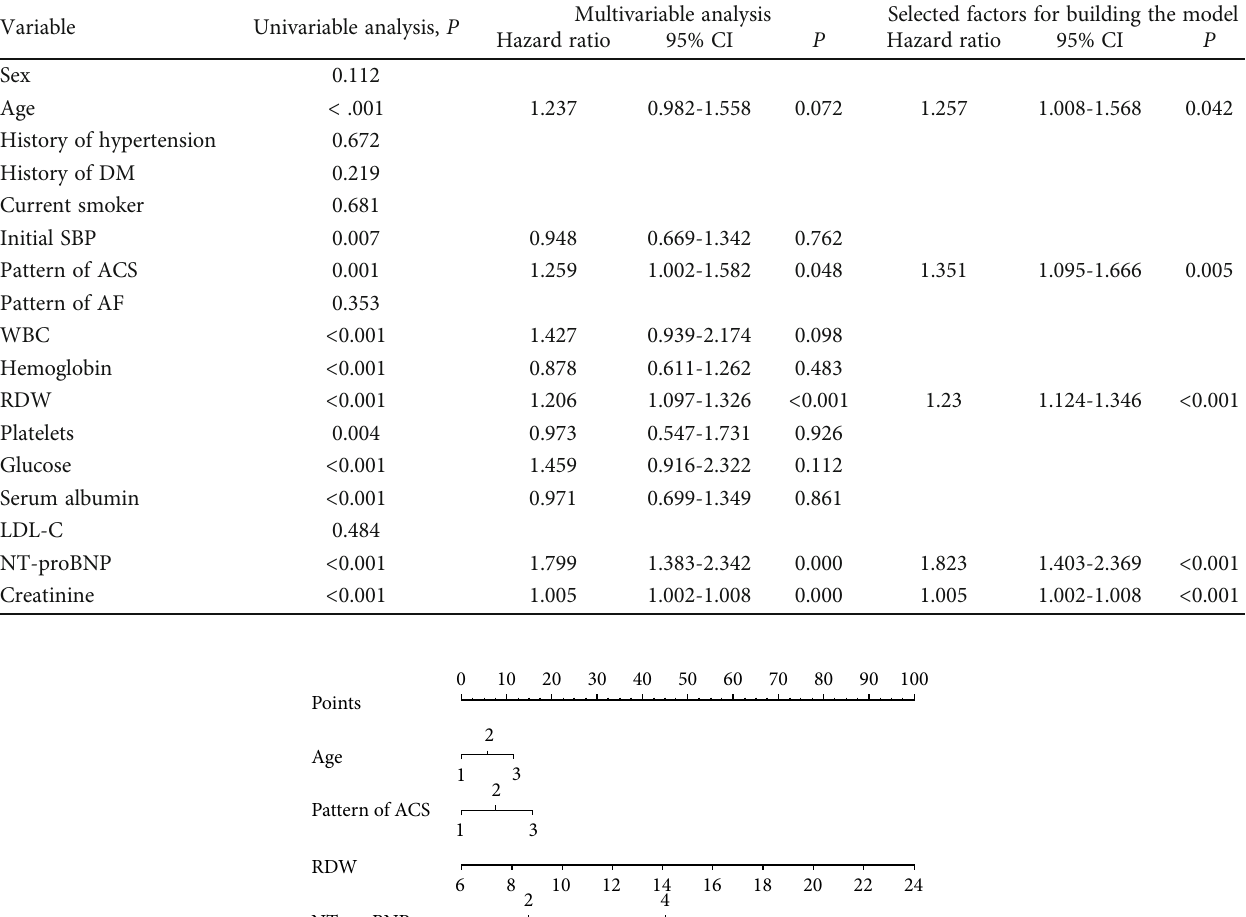
Table 2: Univariable analysis and Cox proportional hazards regression analysis.